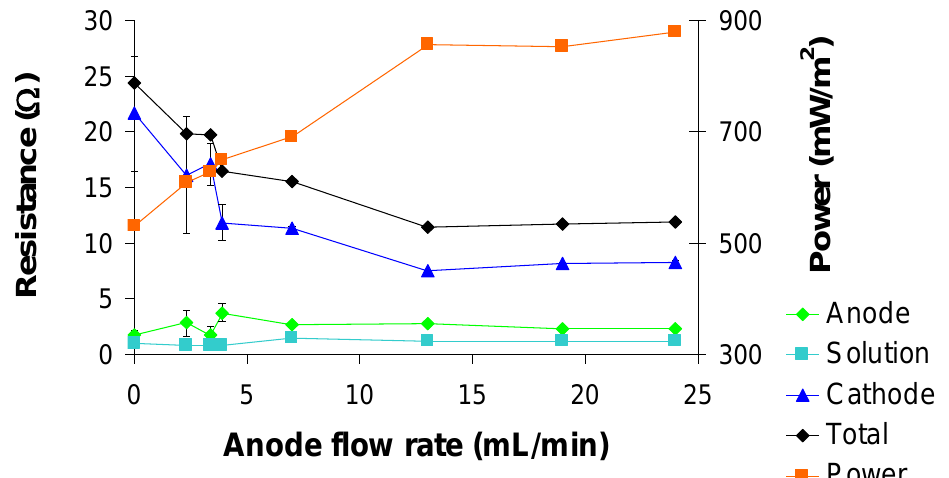
Figure 6. ECM analysis results for EIS data while varying anode fluid flow